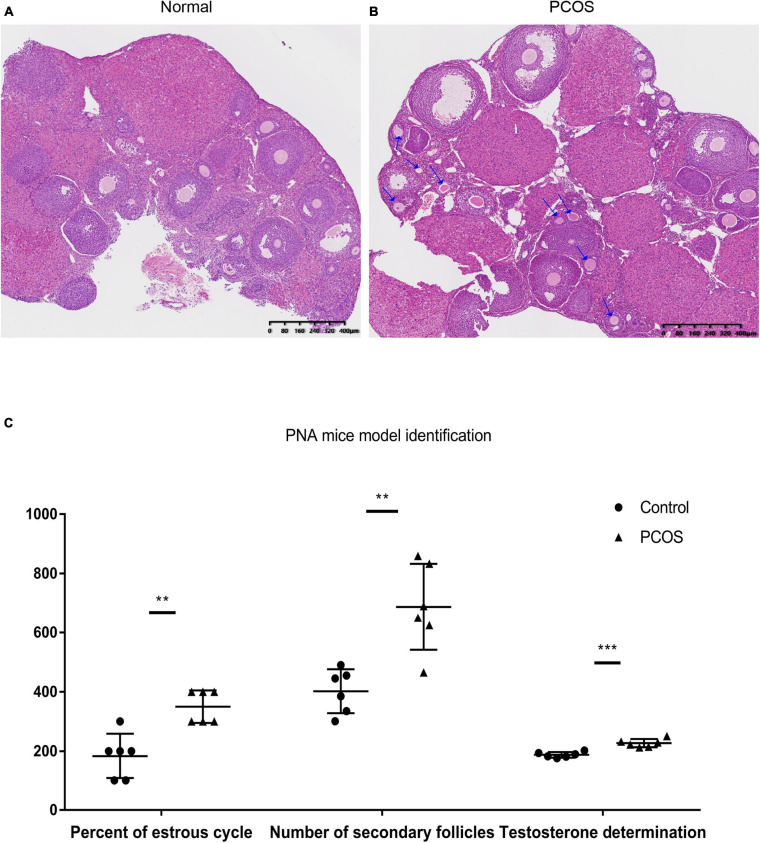
Histological and serological identification of normal (control) and PNA mice ovaries. (A) HE-stained ovarian section of the control group. (B) HE-stained ovarian section of PNA mice; the arrows mark the original follicles. (C) Determination of serum testosterone, number of secondary follicles, and proportion of estrus in PNA mice and control group (**p < 0.01, and ***p < 0.001; the proportion of estrus data multiplied by 100 to ensure the height of the ordinate with no change of p-value).